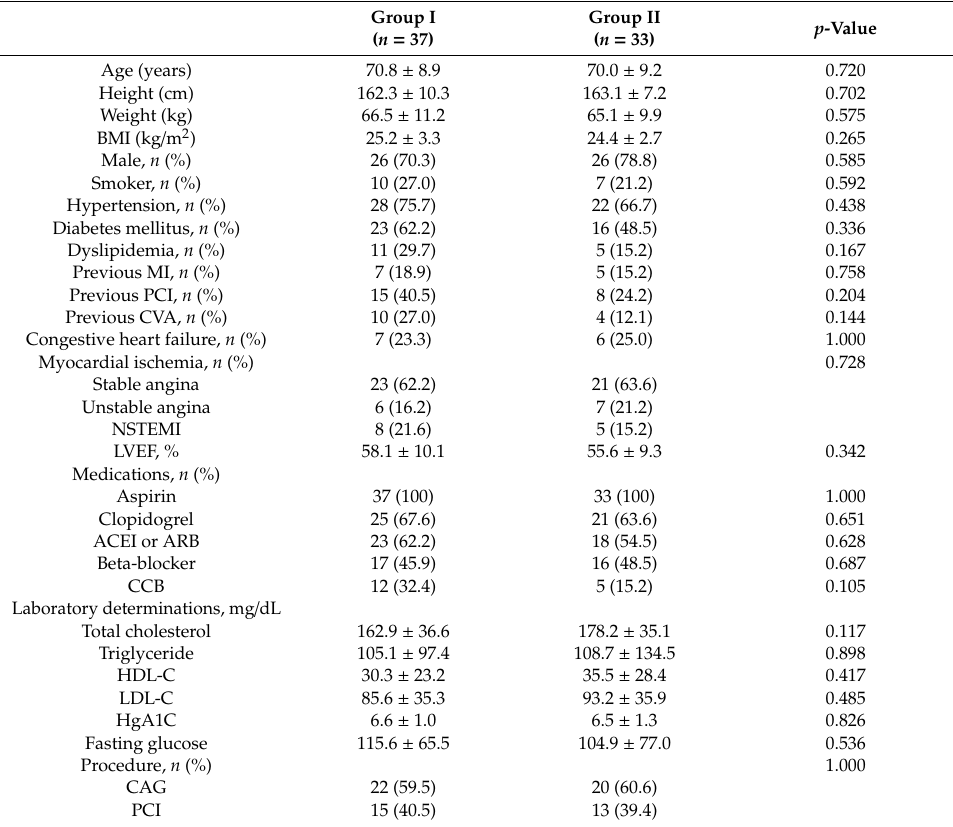
Table 1. Baseline characteristics of patients.